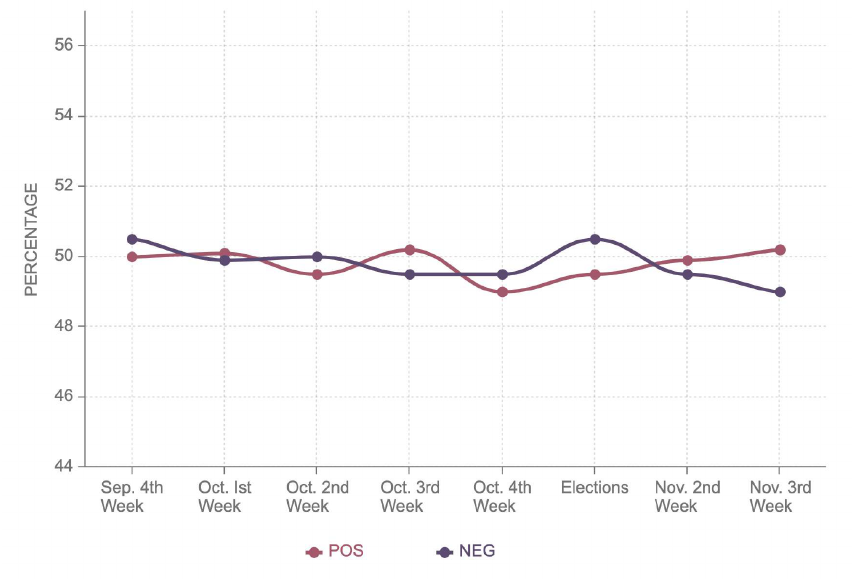
Figure 8. Graphs of positive and negative sentiments of Joe Biden in